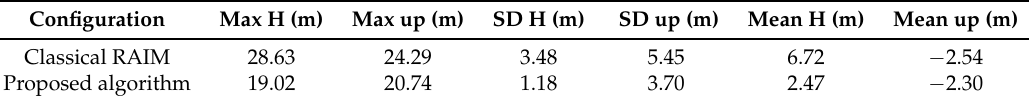
Table 12. Position error statistics considering only common reliable epochs. Classical RAIM is used as the term of comparison.